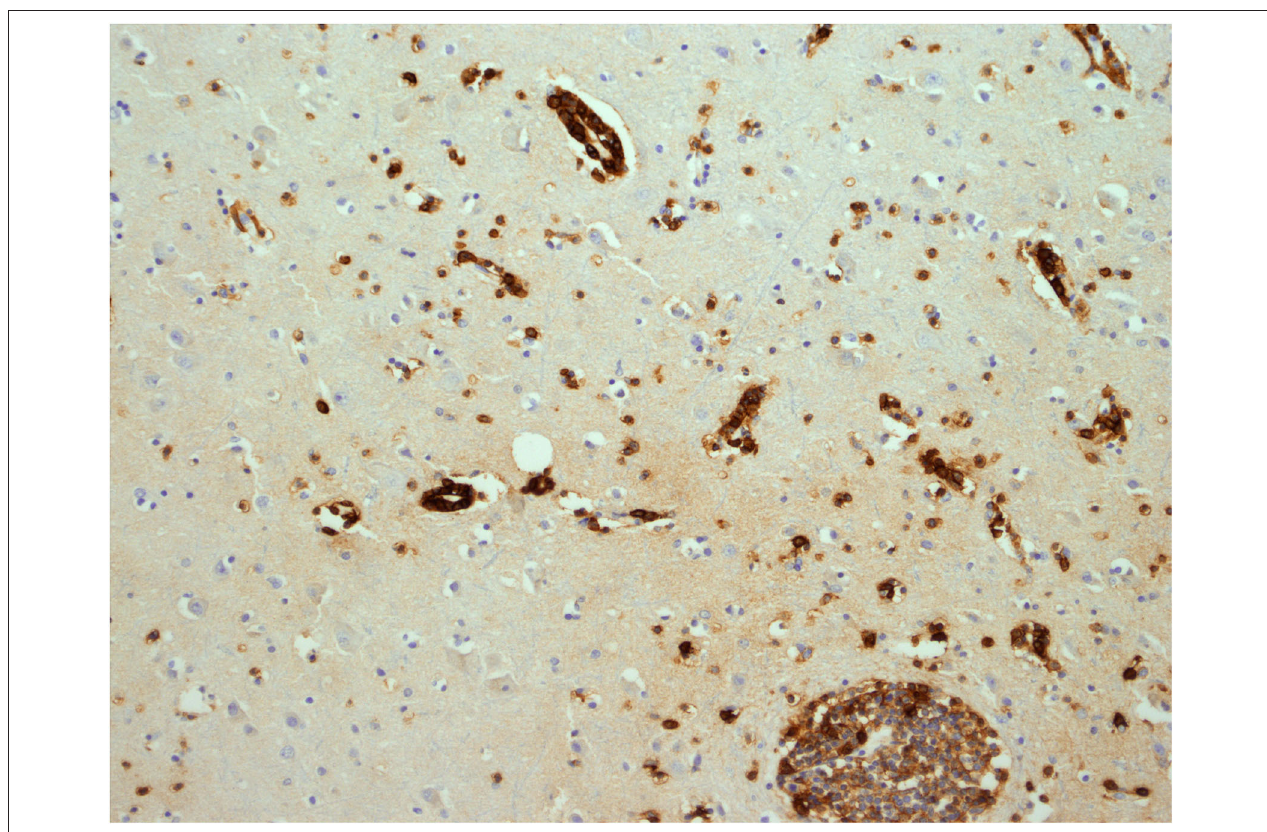
FIGURE 9 | Cerebral white matter: CD38 + activated T-cells, demonstrated with immunohistochemistry (antibody against CD38). Original magnification ×